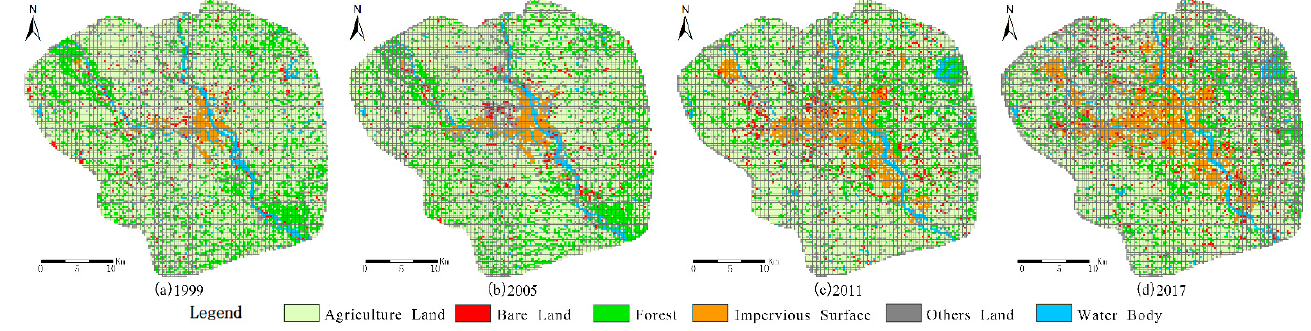
Figure 1. Land use and land cover change in 1999–2017. Table 2. The growth intensity index of different types of